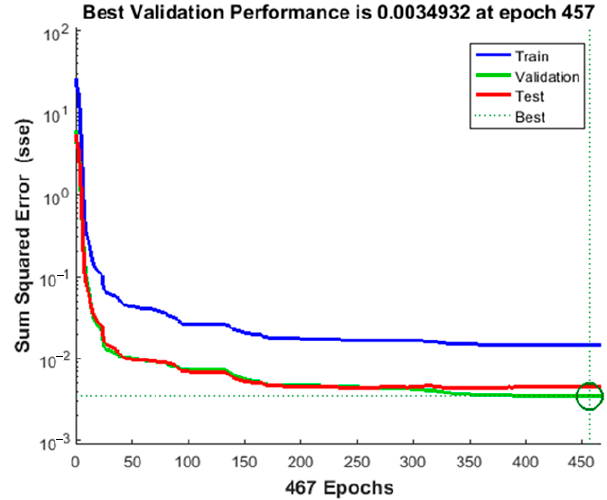
Figure 10. Training results of the BP neural network.